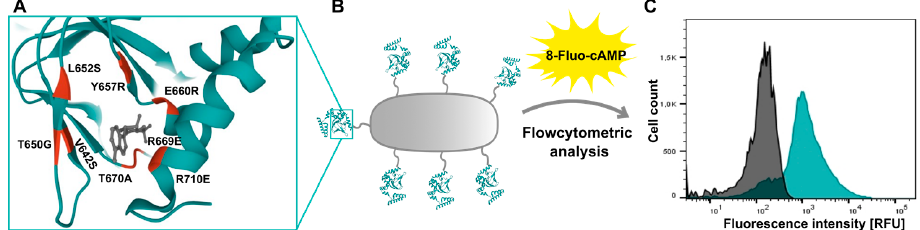
Figure 10. Schematic workflow representation. ( A ) Illustration of amino acids (red) mutated within the HCN4-CNBD with bound cAMP (PDB:3OTF). ( B ) E. coli cells presenting the HCN4-C-Linker- CNBD fusion protein on their surface were treated with 8-Fluo-cAMP followed by flow cytometric analysis. ( C ) Example histogram showing the fluorescence intensity of cells with bound (green) and unbound (black) ligand.